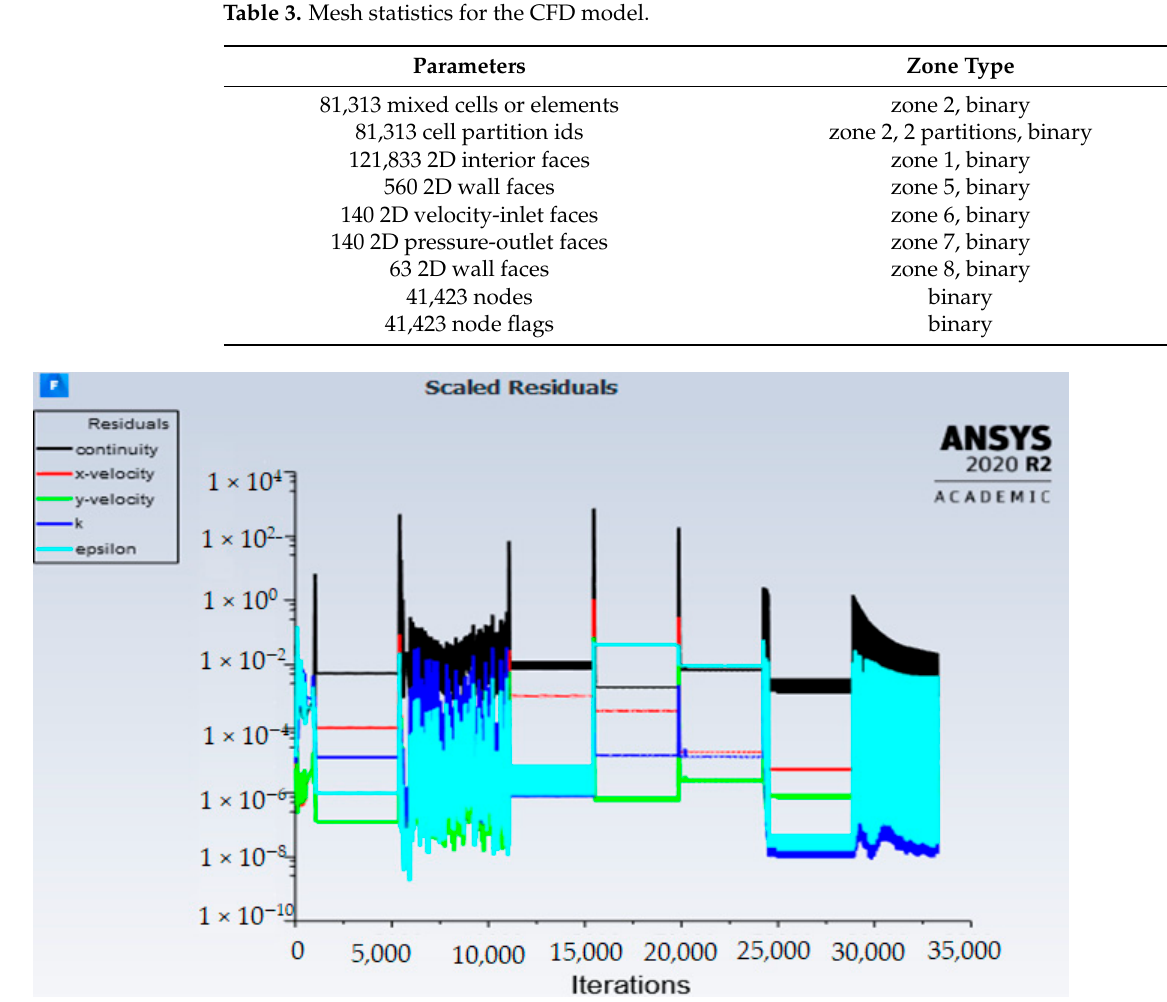
Figure 7. Convergence plot in ANSYS Fluent showing the scaled residuals.